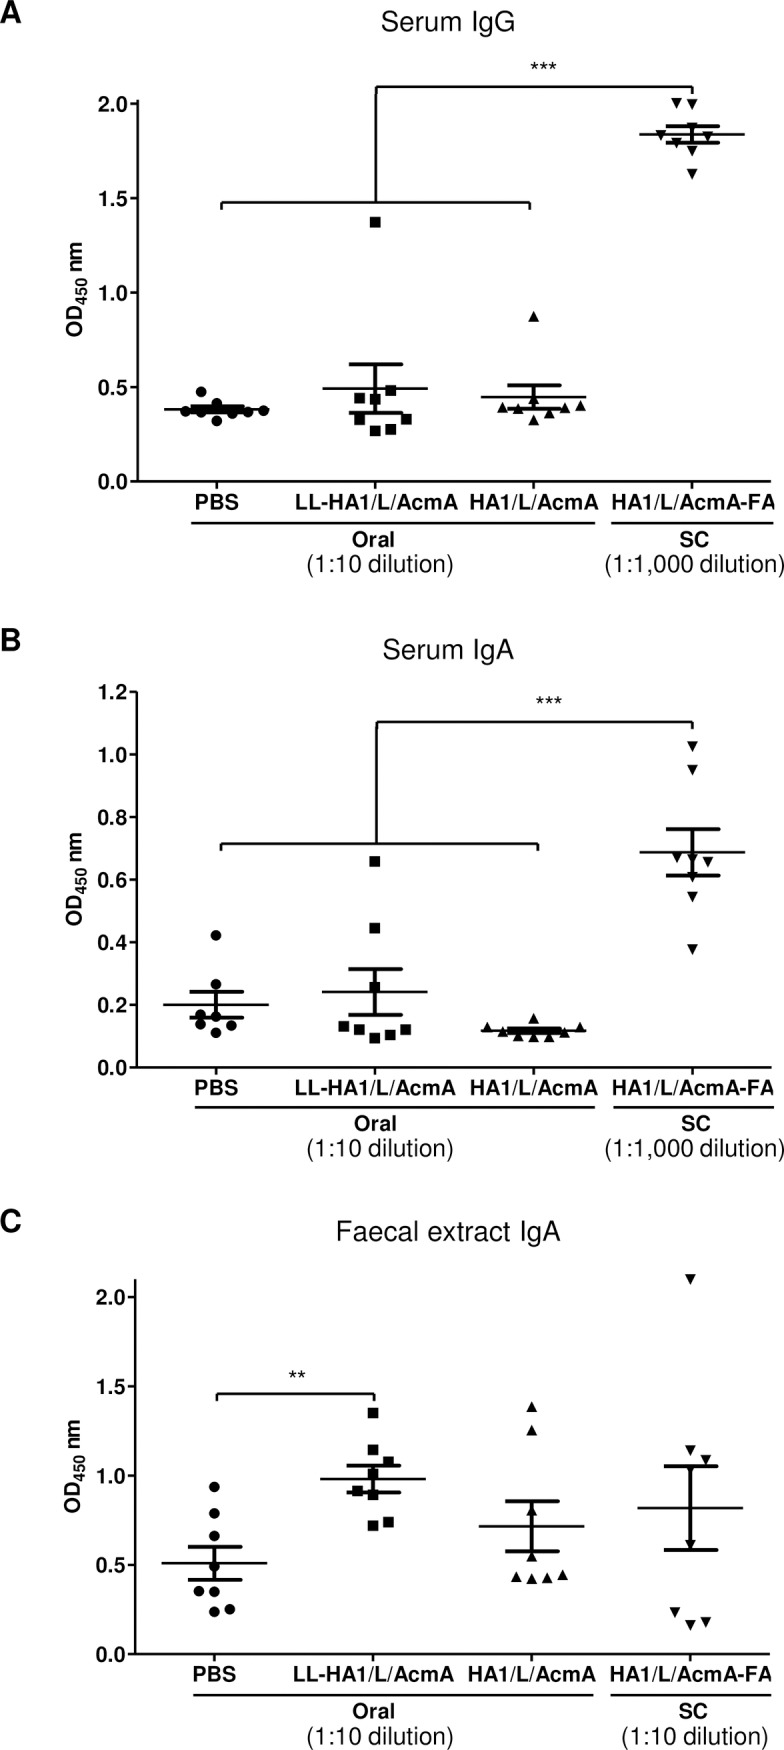
HA1/L/AcmA-specific serum IgG, serum IgA and faecal IgA detected by ELISA.Mice (8 mice/group) were orally immunized with PBS, LL-HA1/L/AcmA or HA1/L/AcmA, or subcutaneously (SC) immunized with HA1/L/AcmA-FA. Serum and faecal samples were collected 2 weeks after the last immunization. (A) HA1/L/AcmA-specific serum IgG, (B) serum IgA and (C) faecal IgA from individual mouse were determined. Data are presented as mean ± standard error of the mean. Asterisks indicate statistically significant differences between the corresponding groups (**p<0.01; ***p<0.001).